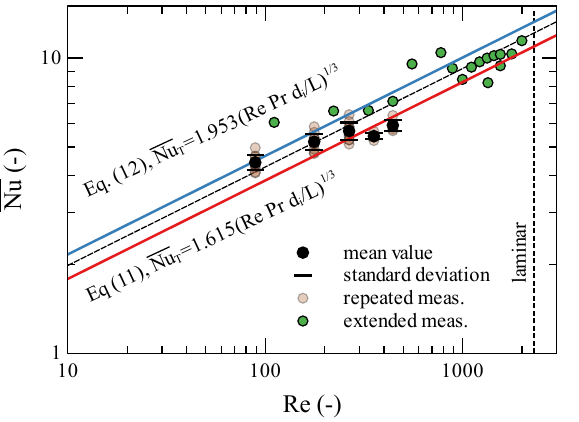
Figure 12. Comparison of average values of Nusselt number as a function of Reynolds number. The dashed black line represents the end of laminar flow (Re =